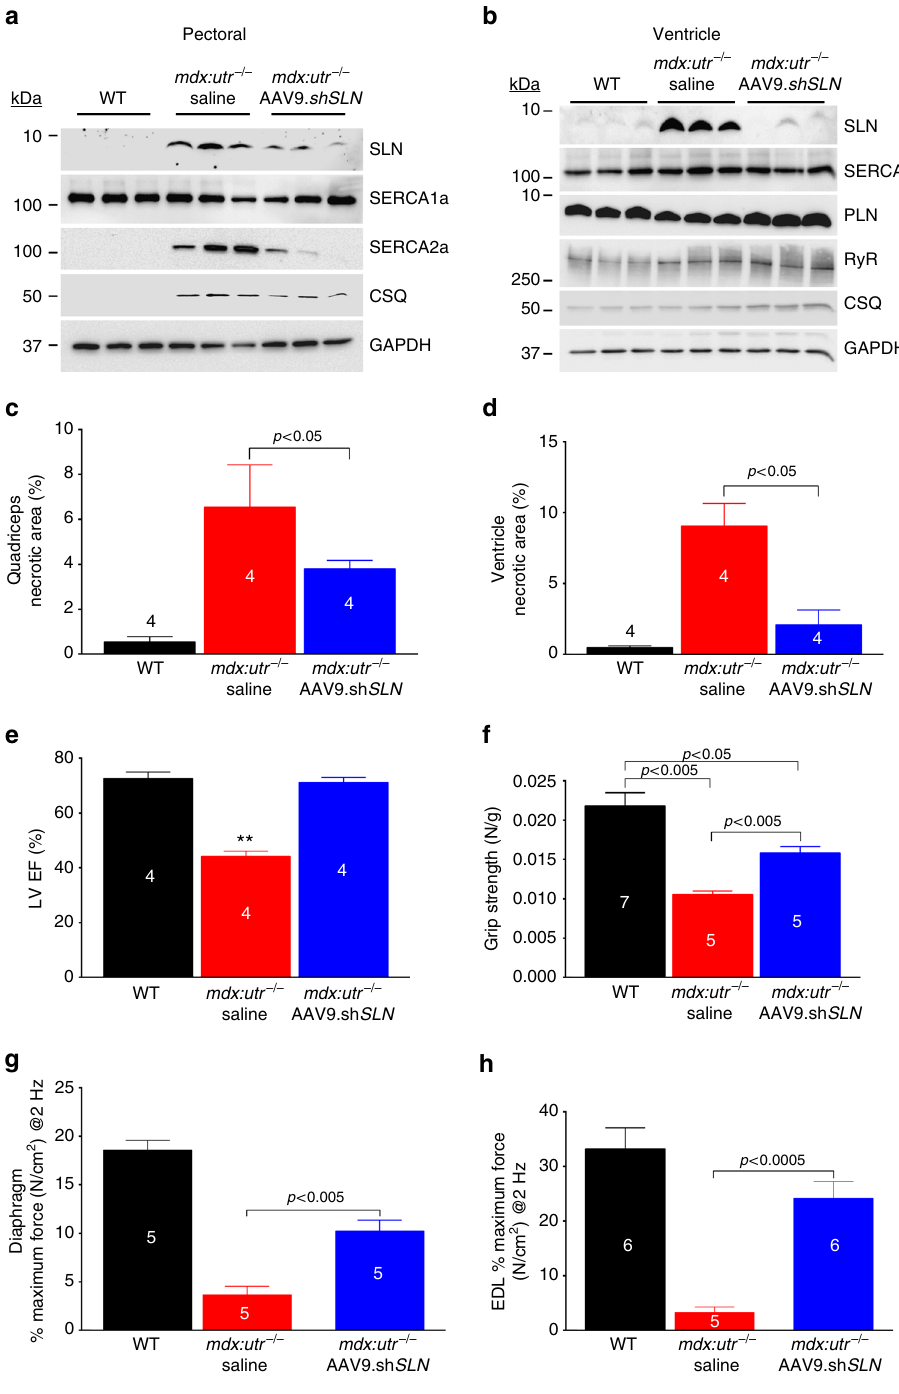
Fig. 6 Postnatal AAV9.sh SLN treatment ameliorates DMD and associated cardiomyopathy in mdx:utr − / − mice. 1-month old male and female mice are injected with AAV or saline and experiments are performed 12 weeks post-injection. a , b Representative western blots show that AAV9.sh SLN treatment effectively reduces SLN expression in skeletal (pectoral muscle) and cardiac (ventricle) muscles. Uncropped scans of western blots are shown in Supplementary Fig. 8d, e. The AAV treatment reduced SERCA2a and CSQ levels in the pectoral muscles of mdx:utr − / − mice. c , d Quantitation of areas with mononuclear in fi ltration in the H&E stained tissue sections show that cell necrosis is signi fi cantly reduced in both quadriceps and ventricles of AAV treated mdx:utr − / − mice compared to that of saline injected mdx:utr − / − controls. Data are presented as mean ± SEM. The n number for each group and the p values ( t -test with Welch ’ s correction) are shown within the graph. e LV EF, f forelimb muscle strength, and g , h the maximum twitch force generated by EDL and hemidiaphragm at 2 Hz are signi fi cantly improved in the AAV treated mice compared to that of saline injected mdx:utr − / − controls. ** p < 0.0001 vs. other groups. Data are presented as mean ± SEM. The n number for each group and the p values ( t -test with Welch ’ s correction) are shown within the